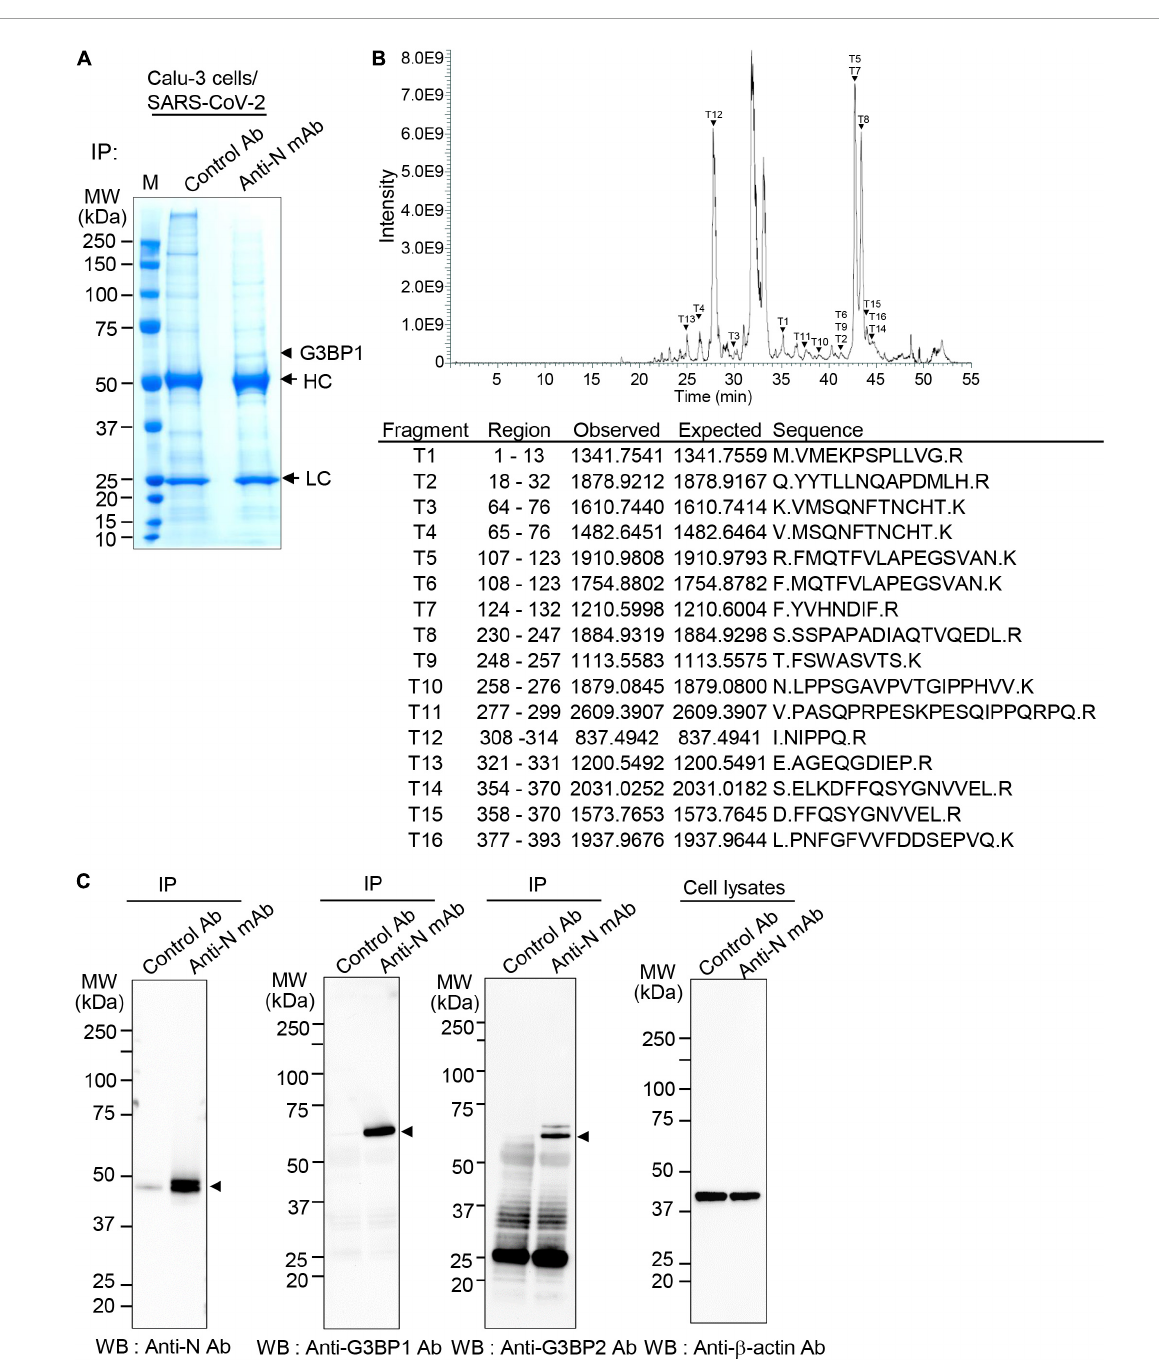
FIGURE1 Interaction between severe acute respiratory syndrome coronavirus 2 (SARS-CoV-2) nucleocapsid (N) protein and Ras-GTPase-activating SH3-domain-binding protein 1 (G3BP1) (A) Co-immunoprecipitation (Co-IP) experiments to identify N protein-binding partners. Calu-3 cells were mock-infected or infected with SARS-CoV-2 S clade at 0.1 multiplicity of infection (MOI); lysates prepared at 72 h post-infection were immunoprecipitated with control antibody (normal IgG) or anti-SARS-CoV-2 N monoclonal antibody (mAb). HC, heavy chain. LC, light chain. (B) Identification of G3BP1. The ∼ 52.1 kDa protein band interacting with SARS-CoV-2 N protein in Co-IP experiments (A) was in-gel digested with trypsin, and the 18 peptides were analyzed by liquid chromatography-tandem mass spectrometry (LC-MS/MS). MS/MS analyses of mass peaks (arrows) reveal the peptide spectra of G3BP1. (C) Co-IP experiments to confirm interaction between SARS-CoV-2 N protein and G3BP1. Co-IPed immunocomplexes from panel (A) were subjected to western blot analysis with the indicated antibodies; anti- β -actin antibody was used as the input control. IP, immunoprecipitation; WB, western blot; Anti-N mAb, anti-SARS-CoV-2 N mAb (clone 1G10C4 mAb); Anti-N Ab, anti-SARS-CoV-2 N polyclonal